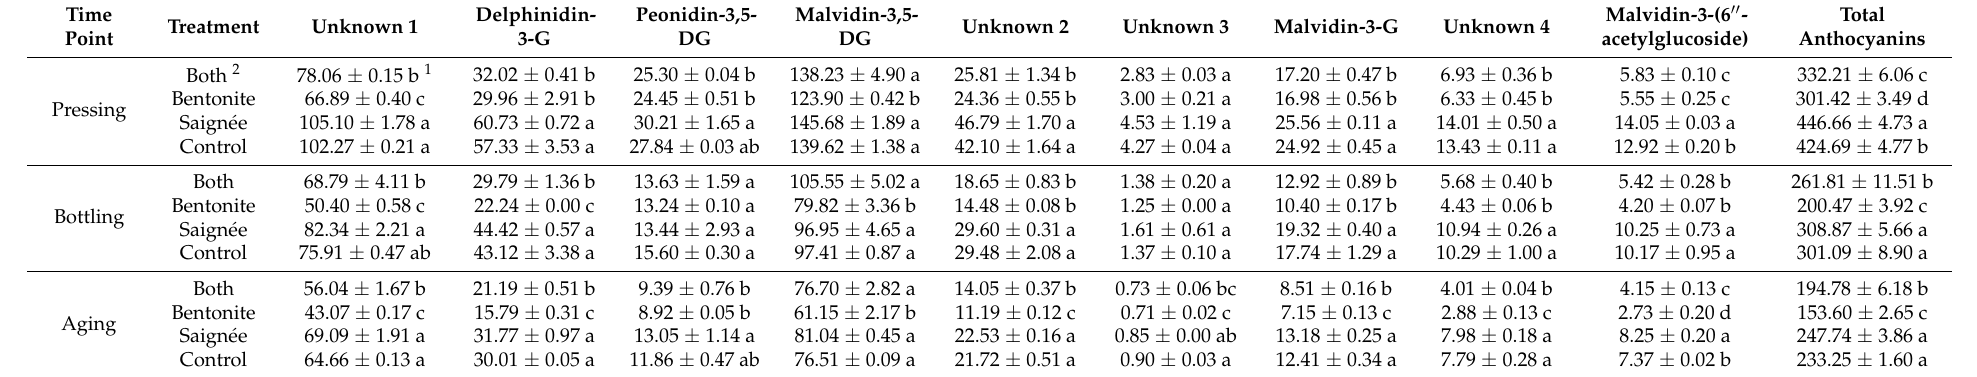
Table 2. Monomeric anthocyanins content in Marquette grape musts and wines (in mg/L). (3-G = glucoside, 3,5-DG = diglucoside). Data were expressed as mean of replicate ( n = 2) ± standard deviation.